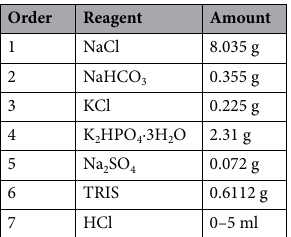
Table 1. Composition of the simulated body fluid used in this work (1000 ml of the